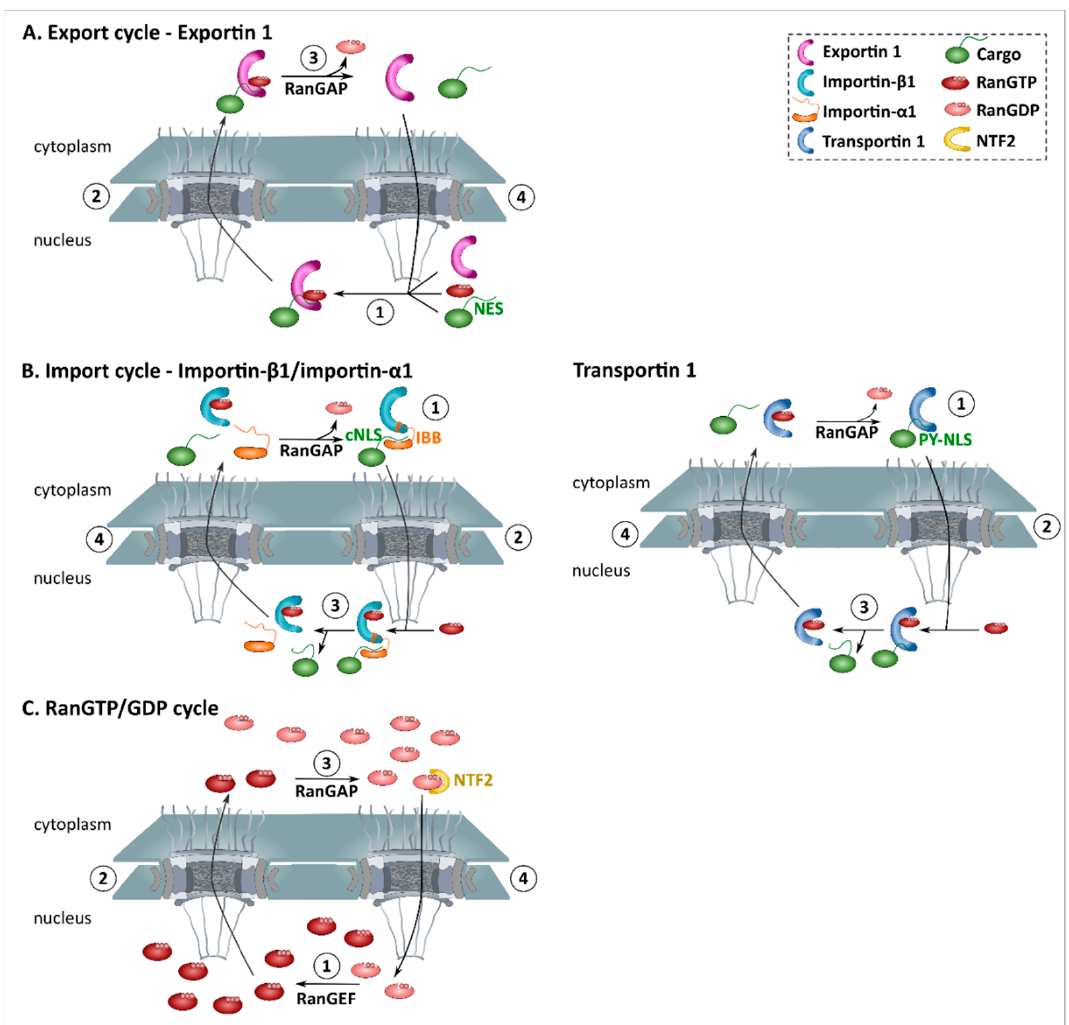
Figure 2. Schematic representation of Ran-dependent nucleocytoplasmic transport. Transport across the NPC is achieved by nuclear transport receptors, importins and exportins, and powered by a RanGTP gradient. ( A ) Nuclear export. ( 1 ) In the presence of high RanGTP concentrations, exportin 1 is able to bind cargoes containing a nuclear export signal (NES). ( 2 ). As exportin 1 has the unique ability to interact with the FG-repeats of the central channel, the exportin-cargo complex undergoes rapid passage through the pore. ( 3 ) In the cytoplasm, hydrolysis of RanGTP to RanGDP will cause the release of the cargo. ( 4 ) Exportin 1 is recycled back to the nucleus. ( B ) Nuclear import. ( 1 ) Due to the low affinity for RanGDP, importins bind their cargo in the cytoplasm. Left panel: a protein containing a classical nuclear localization signal (cNLS) is bound by the adaptor importin- α , which subsequently binds importin- β 1 via its importin- β -binding domain (IBB). Right panel: proteins containing proline-tyrosine-nuclear localization signal (PY-NLS) are recognized by transportin 1. ( 2 ) Importins can transiently open the FG-meshwork of the central channel, allowing the passage of bound cargo. ( 3 ) In the nucleus, binding of RanGTP induces conformational changes, which induces cargo release. ( 4 ) Importins are exported back to the cytoplasm. ( C ) RanGTP/GDP cycle. ( 1 ) The high concentrations of RanGTP (Ran guanosine triphosphate) in the nucleus is maintained by RanGEF (Ran—guanine exchange factor). ( 2 ) RanGTP undergoes a continuous efflux out the nucleus via its binding to NTRs (see A and B). ( 3 ) RanGAP (Ran—GTPase activating protein) mediated hydrolysis of RanGTP into RanGDP, resulting in high concentrations of RanGDP (Ran guanosine diphosphate) in the cytoplasm. ( 4 ) RanGDP is imported into to the nucleus by NTF2 (nuclear transport factor 2) to restore depleted nuclear levels of RanGTP. Image is based on the review of Cook et al. [65].